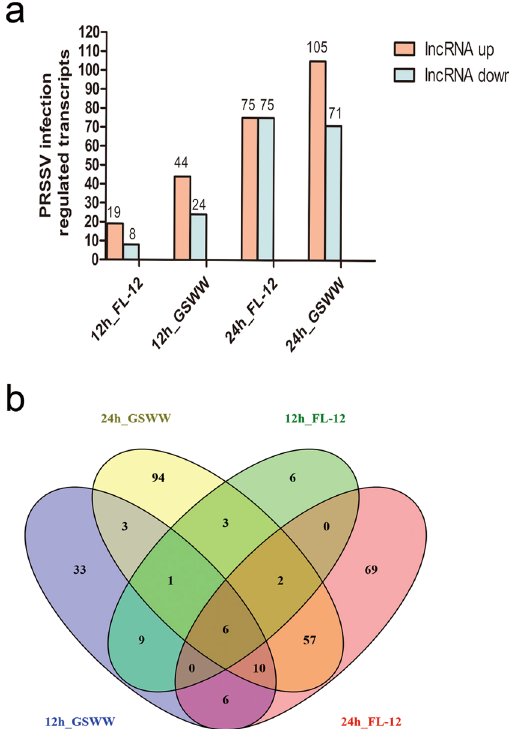
Figure 1. Numbers of differentially regulated genes after PRRSV infection. ( a ) Numbers of up- and down- regulated lncRNAs in four comparison groups (12h_GSWW vs. 12h_Mock, 12h_FL-12 vs. 12h_Mock, 24h_GSWW vs. 24h_Mock and 24h_FL-12 vs. 24h_Mock). The expression levels of lncRNAs were calculated by Cuffdiff on the basis of FPKM values. Differentially expressed lncRNAs were filtered by the cutoff p value ≤ 0.05. The lncRNAs showing the same alterations in two biological repeats were considered significantly differentially expressed. ( b ) Venn diagram illustrating common differentially expressed genes in four comparison